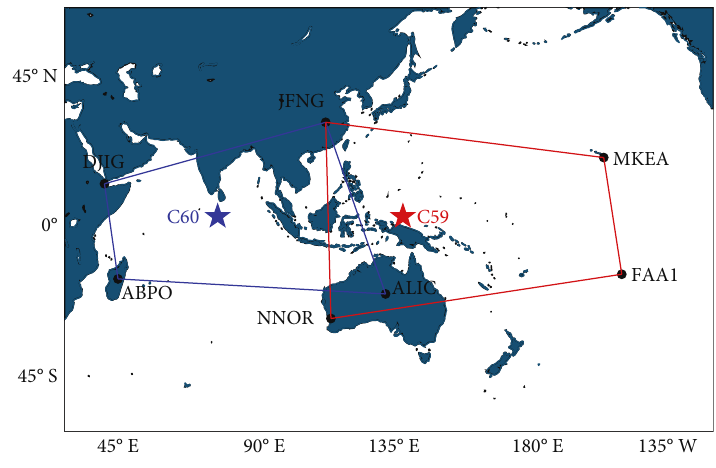
Figure 5: Locations of selected stations. Table 1: Details of the selected